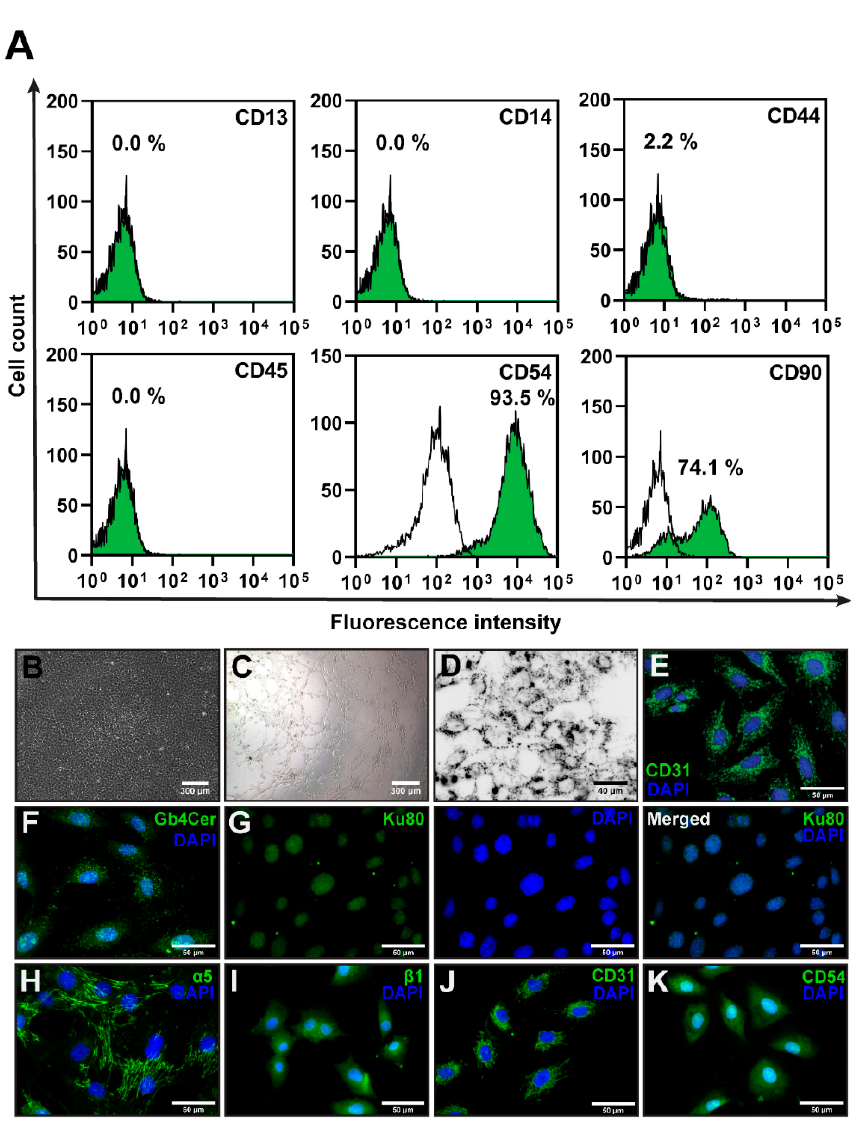
Figure 1. Characterization of the endothelial cells (EC). ( A ) A flow cytometry analysis of the CD13, CD14, CD44, CD45, CD54, CD90 surface markers on EC isolated from Wistar rats’ pulmonary trunk blood vessels (PTEC). White—EC histogram marked with isotopic control, Green—cells labelled with R-phycoerythrin fluorescent dye conjugated antibodies. ( B ) PTEC monolayer. ( C ) PTEC tube-like structures formed on a Matrigel-coated surface. ( D ) The uptake of Alexa Fluor ® 488 labeled Ac-LDL by PTEC (Ac-LDL is shown in black). ( E ) An immunofluorescent image of CD31-stained PTECs. ( F – I ) The surface expression of primary B19V receptor P antigen (Gb4Cer) and coreceptors Ku80 and α 5 β 1-integrins in PTEC. ( J , K ) Human umbilical vein endothelial cells (HUVECs’) surface expression of CD31 and